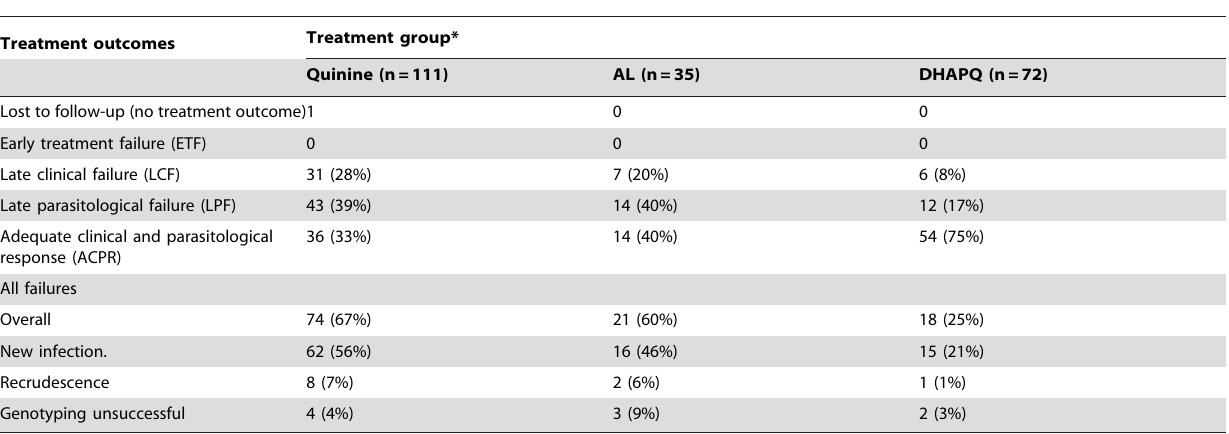
Table 2. WHO treatment outcomes after 28 days of follow-up.